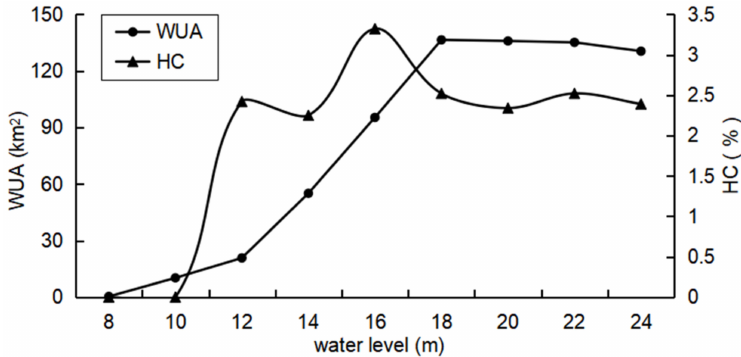
Figure 9. WUA and HC for the migratory fish habitat under nine typical water-level